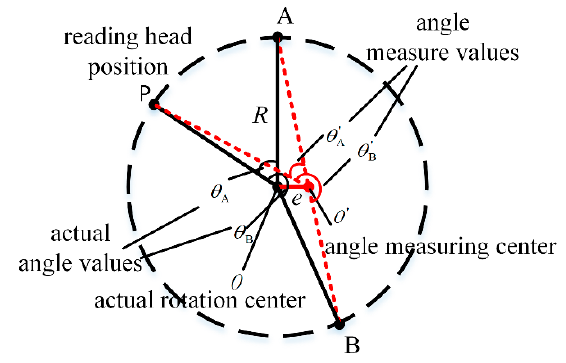
Figure 9. Schematic diagram of eccentric error.